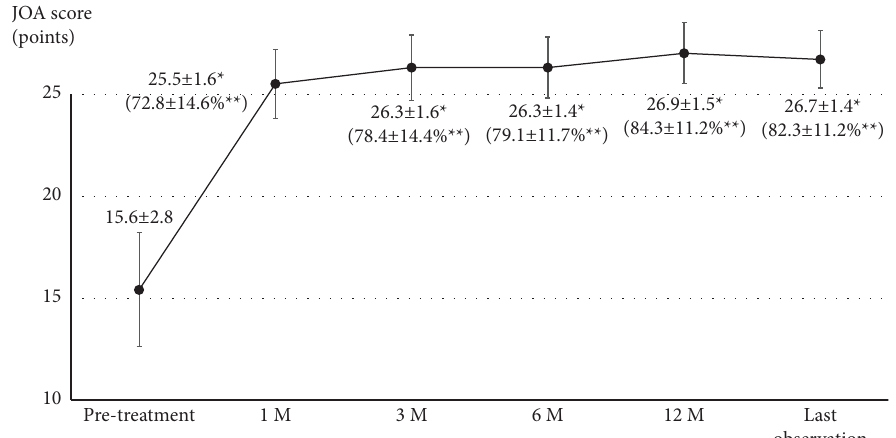
Figure 4: JOA scores from pretreatment to last observation. M, months after treatments; JOA, Japanese Orthopedic Association. ∗ Signifcant diference compared with pretreatment ( P < 0 . 0001); ∗∗ Recovery